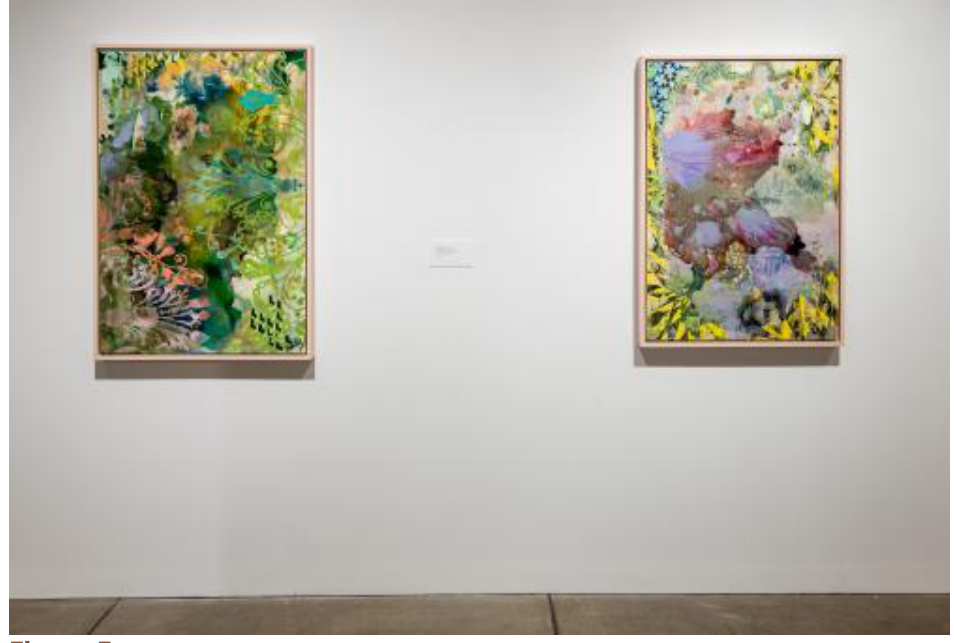
Installation view of Firelei Báez: Bloodlines with (left to right ) Trust memory over history (2015, acrylic and ink on panel, 31.5 x 46.5 in.) and The last one who remembers it (2015, acrylic and ink on panel, 29.5 x 43 in.), The Andy Warhol Museum, Pittsburgh, photograph by Abby Warhola, 2017 .